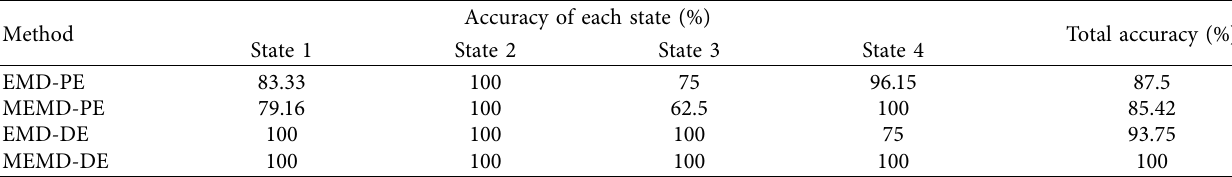
Figure 13: Classification results of SVM. (a) Train sample. (b) Test sample. Table 2: Comparison of classification results of different